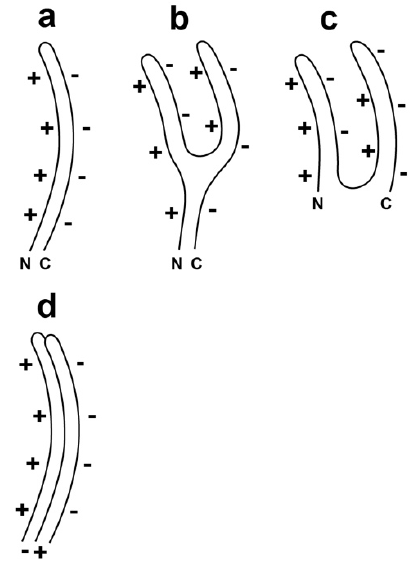
Figure 2. A line drawing of the proposed α-sheet-generating polypeptide backbone of the gp10 subunits of ( a ) hyper-expanded T3/T7 capsid II; ( b ) an intermediate converting from its state in hyper- expanded to its state in contracted capsid II and ( c ) contracted capsid II. N and C indicate the N- and C-terminals of gp10; ( d ) Assembly of two gp10 subunits is shown with the proposed radial staggering. The staggering improves electrical charge-charge-derived energetics. The + symbols indicate the + electrical charge of the α-amino edge; the − symbols indicate the − electrical charge of the α-carboxyl edge.